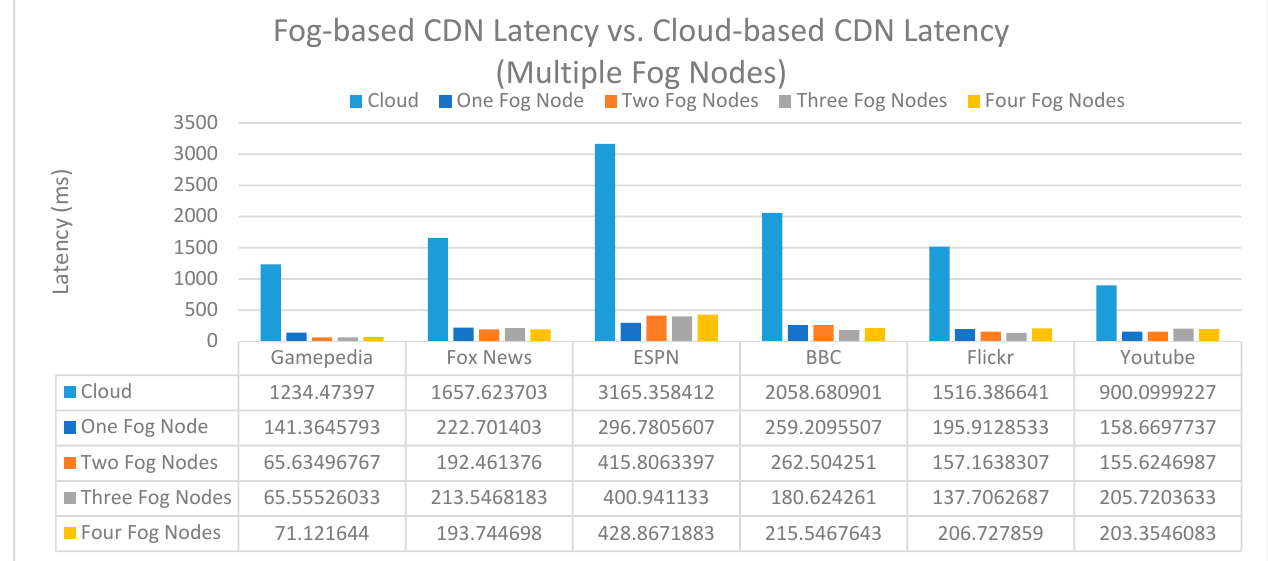
Figure 10. Fog-based CDN latency (multiple fog nodes) vs. cloud-based CDN latency.